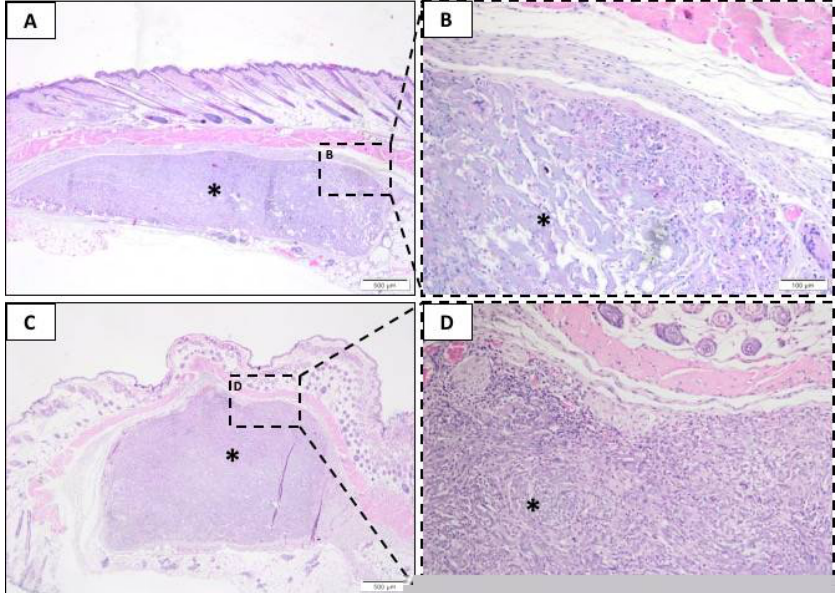
Figure 3. Representative photomicrographs of subcutaneous injury after 21 days. Histological section stained with hematoxylin/eosin from the incision region in the BG groups ( A , B ) and LT groups ( C , D ). The area occupied by the membrane is indicated by an asterisk (*). ( A , C ) 40× magnification, scale bar: 500 µm; ( B , D ) 200× magnification, scale bar: 100 µm.